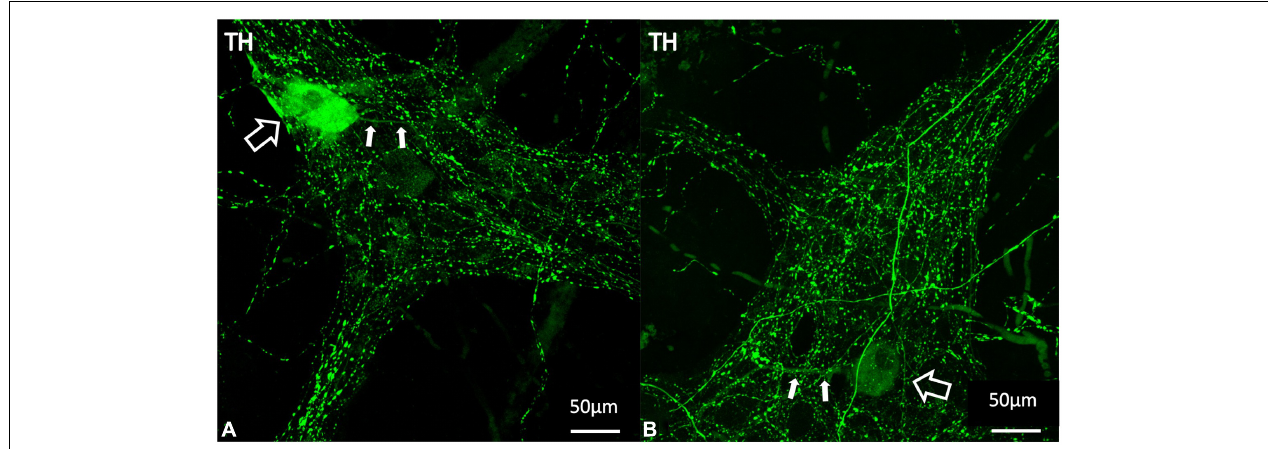
FIGURE 8 | Examples of TH positive myenteric cell bodies (A,B) . TH labelling is shown in green. The larger open white arrows show TH immunoreactive cell bodies and the smaller filled arrows demonstrate single long axonal projections from each of these cells, seen in 10 of the 22 identified TH positive cell bodies. TH immunoreactive cell bodies make up 1% of the total population of myenteric cells and are likely to indicate intrinsic catecholaminergic cells in the myenteric plexus, some of which may be dopaminergic in nature. TH, tyrosine